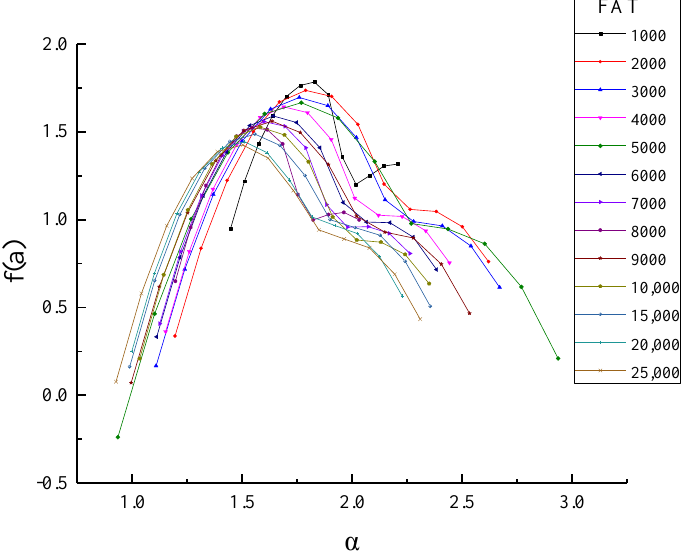
Figure 9. f ( α ) vs. α functions corresponding to several FAT values (Hubei Figure 9. 𝑓(𝛼) vs. 𝛼 functions corresponding to several FAT values (Hubei Province).